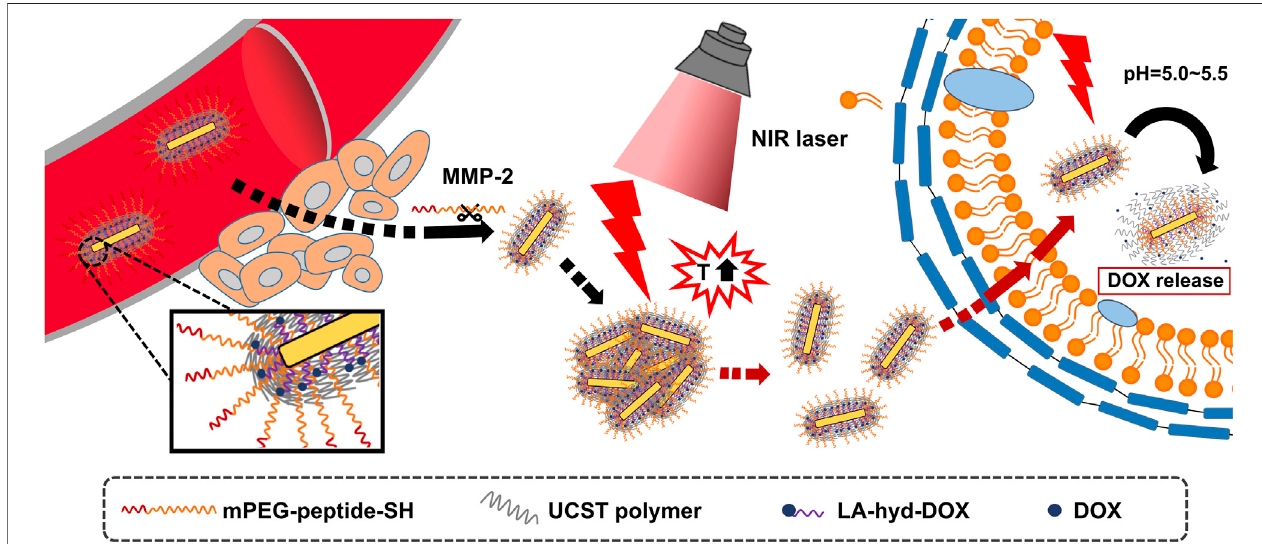
SCHEME 1 | Illustration of the structure of APP-DOX and strategy of drug release at the tumour site.